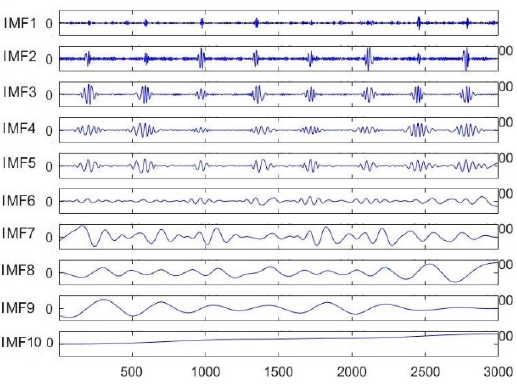
Figure 2. Individual intrinsic mode functions (IMFs) after ECG decomposition.